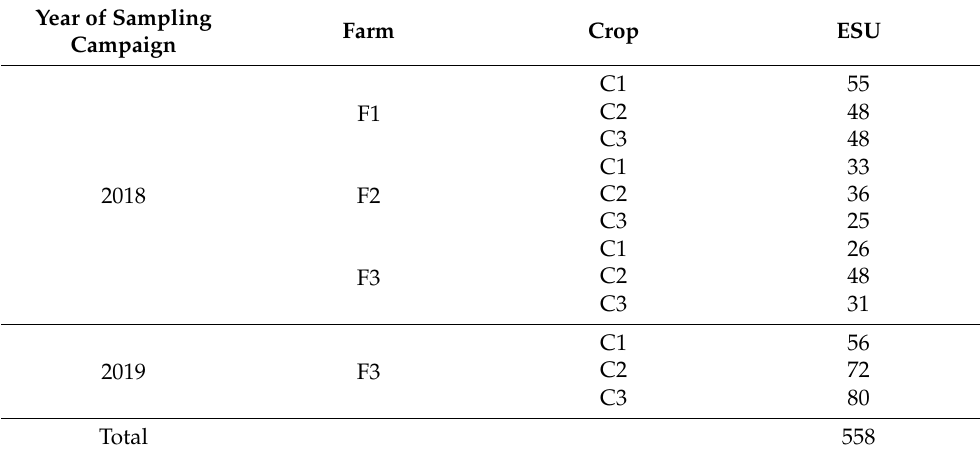
Table 1. Number of ESUs sampled in the three farms (F1, F2, and F3) during the 2018 and 2019 field campaigns for the three crops (C1 = winter wheat; C2 = maize; C3 = alfalfa). Year of Sampling Farm Crop ESU Campaign F1